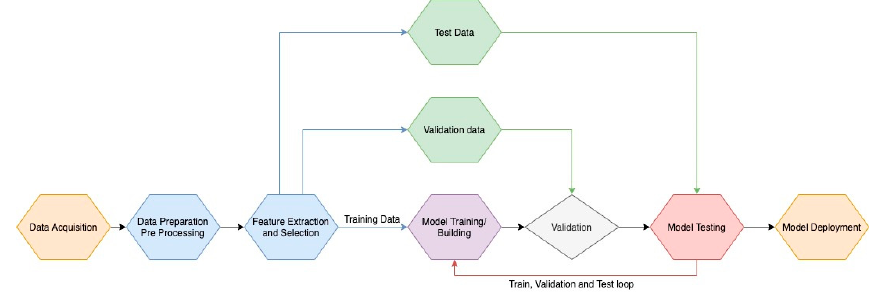
Figure 4. Multimodal emotion classification workflow.